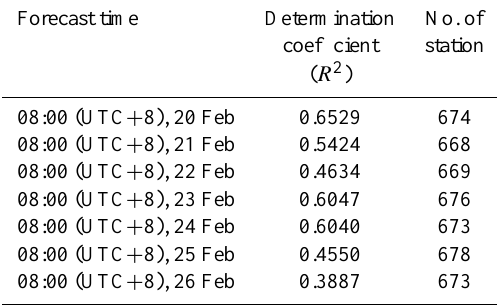
Table 1. Correlation of daily PLAM/h index 24h forecasts and vis- ibility during the whole period of the regional heavy fog-haze event over North China during 20–26 February 2014. Forecast time Determination No.